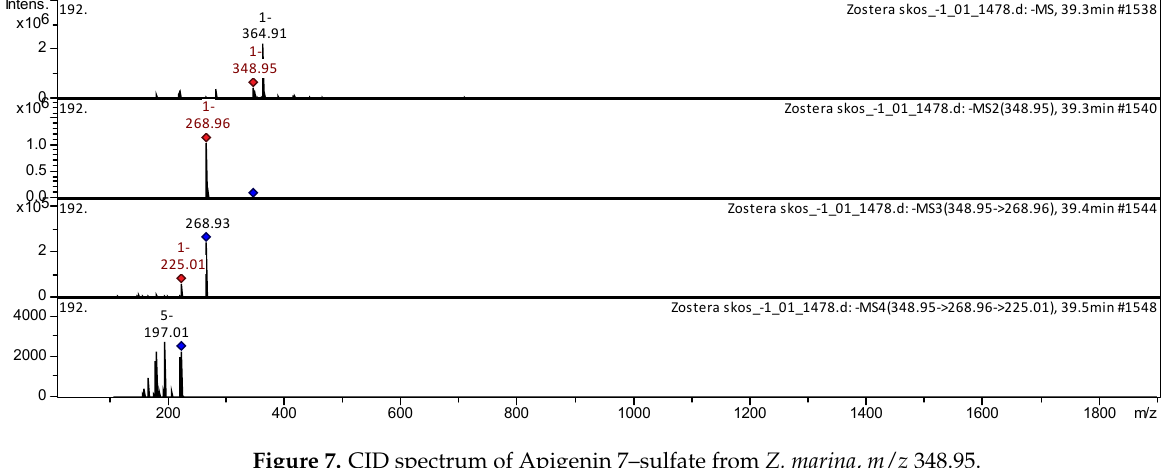
Figure 8. CID spectrum of Pelargonidin 3- O -glucoside acid from Z. marina , m/z 432.55.